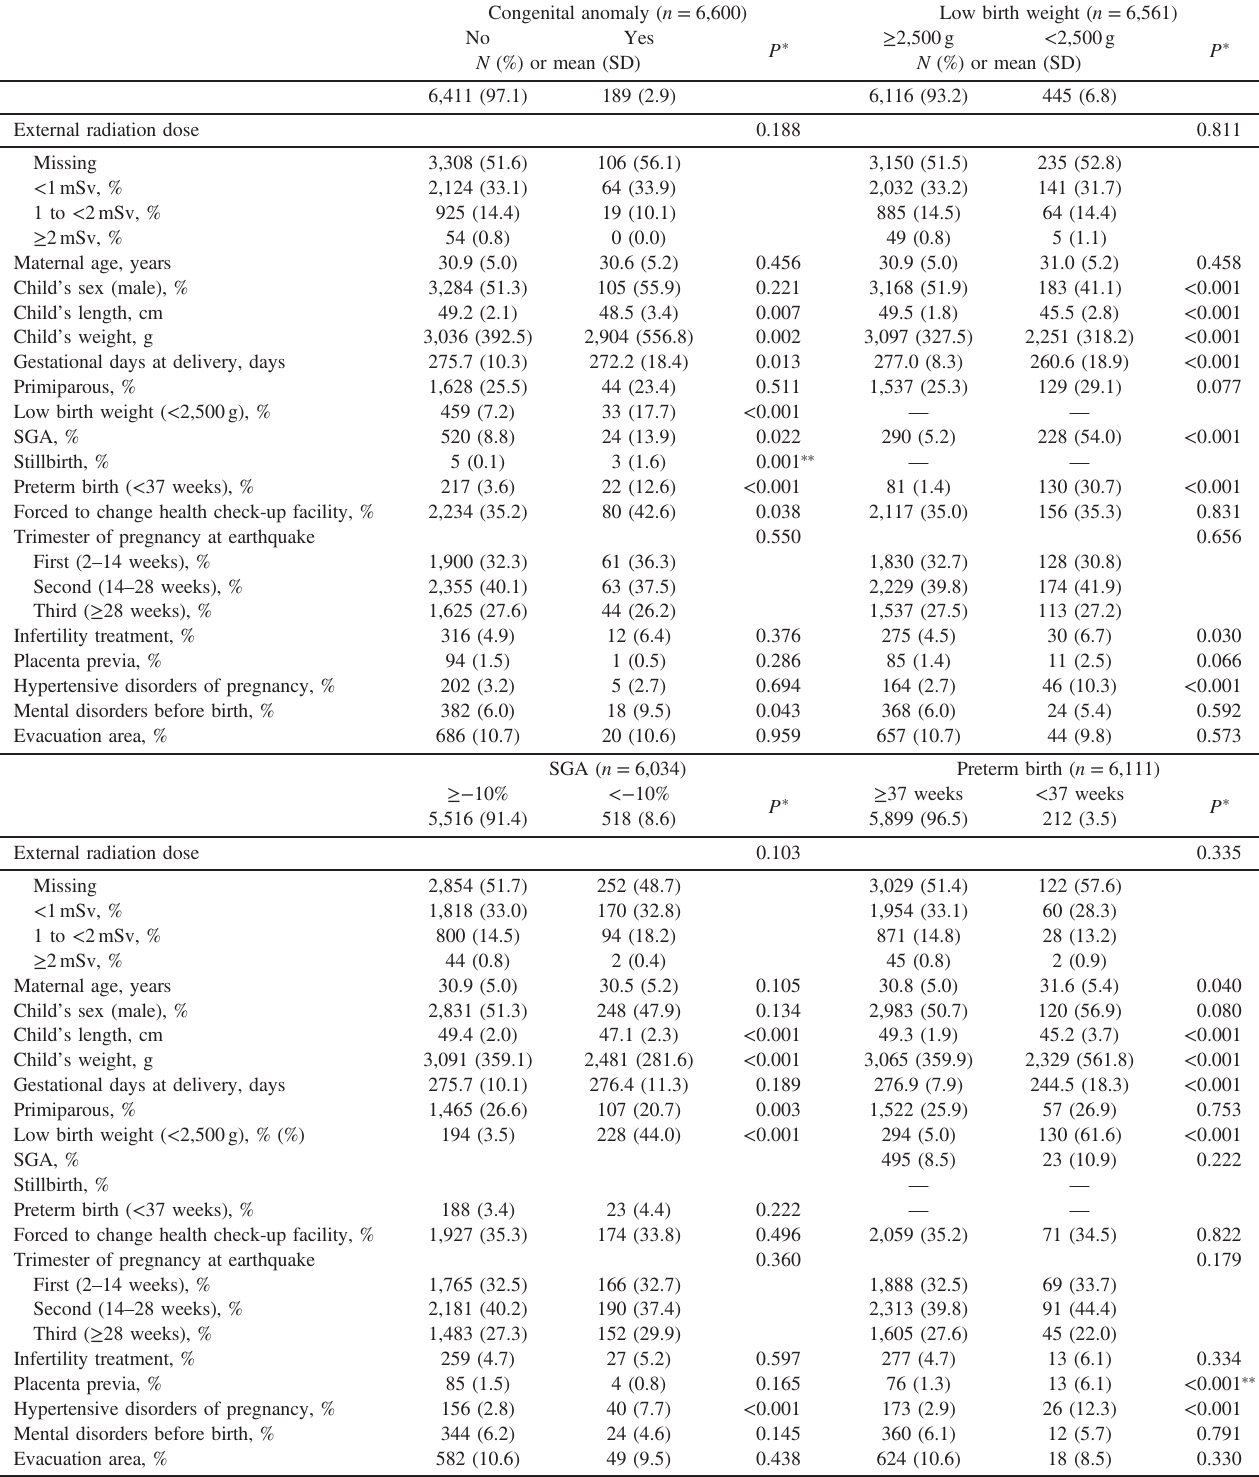
Table 2. Factors associated with preterm birth, low birth weight, SGA, and congenital anomalies